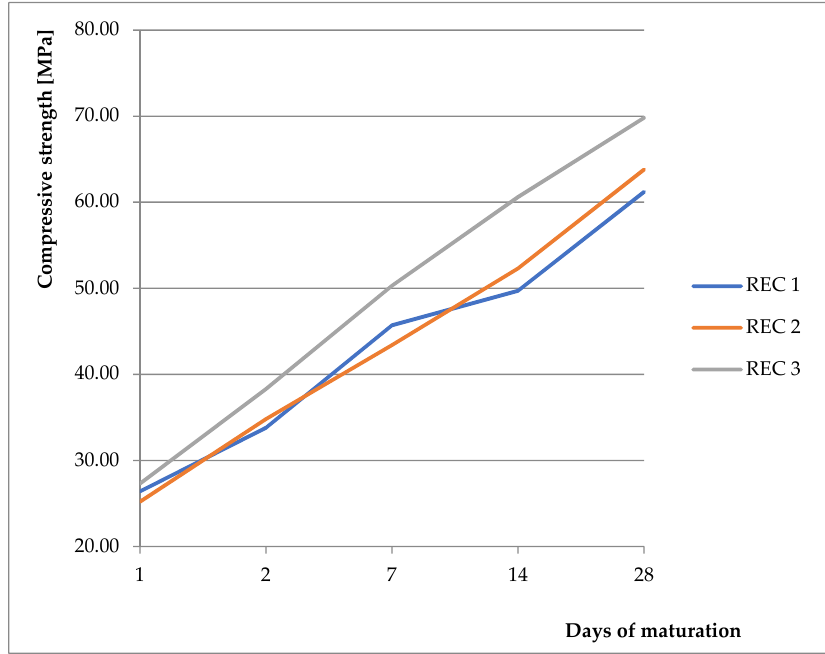
Figure 4. Compressive strength of prepared mixtures.